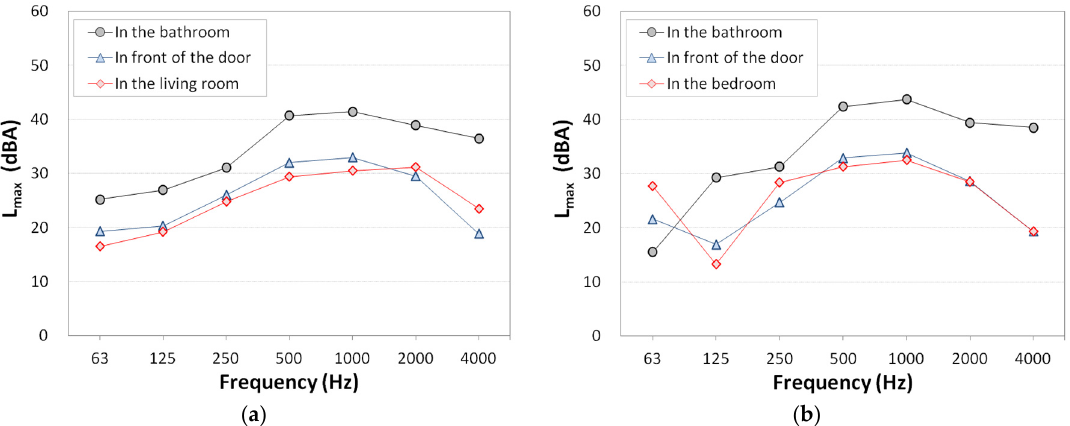
Figure 12. Frequency spectrum of water supply and drainage noises from the use of the water closet measured in the ( a ) living room and ( b ) bedroom of the lower floor for the 59B type.